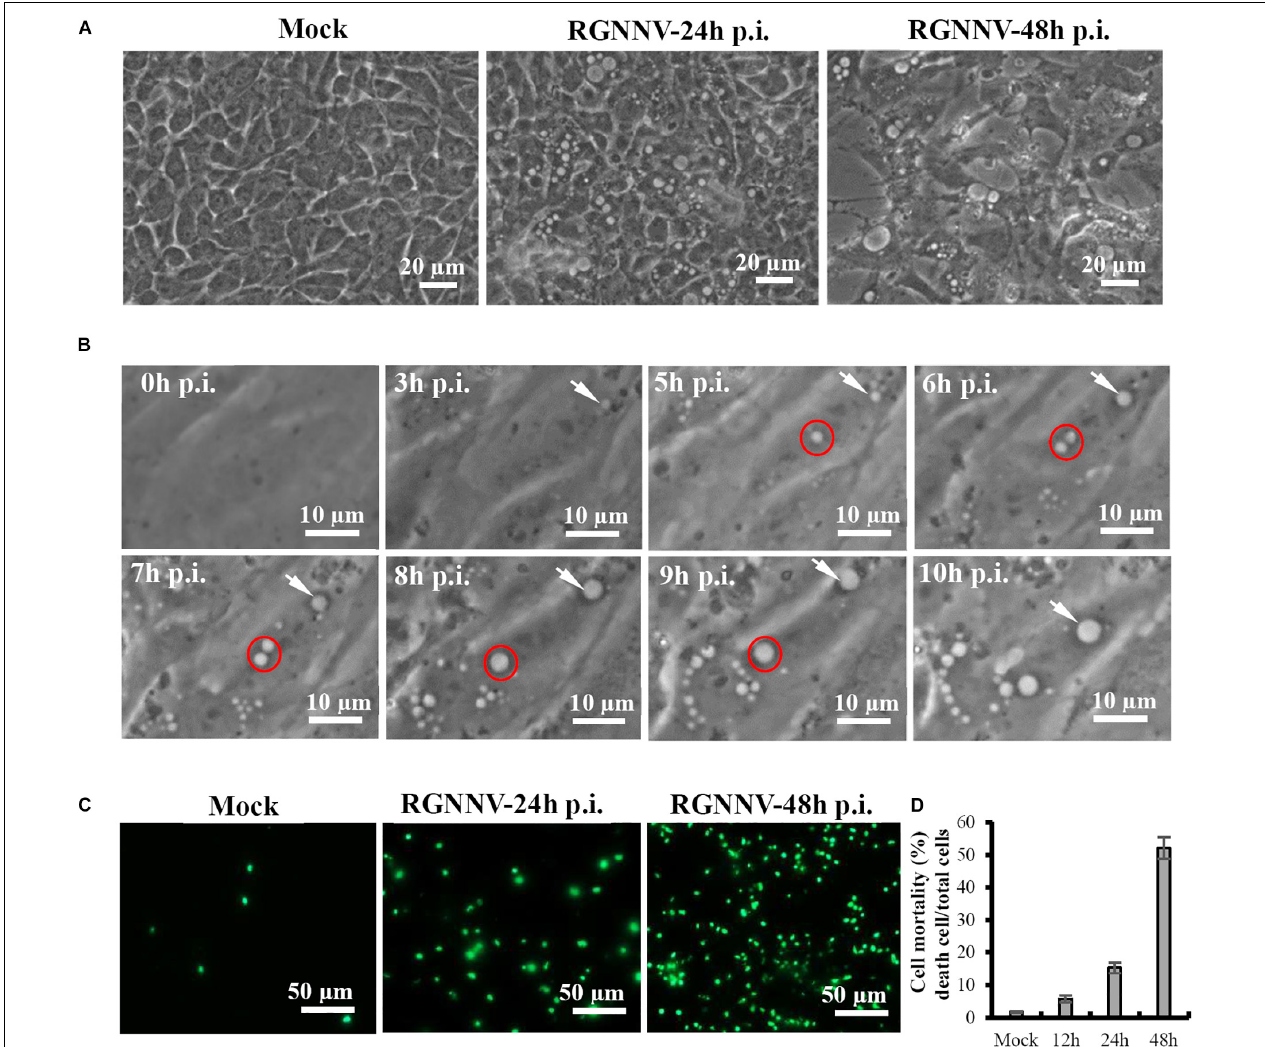
FIGURE 1 | RGNNV induced massive cytoplasmic vacuoles in grouper cells. (A) RGNNV induced massive cytoplasmic vacuoles in GS cells. (B) Time-course observation of vacuoles from 3 to 10 h during RGNNV infection. The arrows indicate enlargement of vacuoles. The circles show the fusion of the vacuoles. (C) Cell death induced by RGNNV infection was determined by Image-It Dead green viability staining. (D) The percentage of the dead cells were quantified using a trypan blue